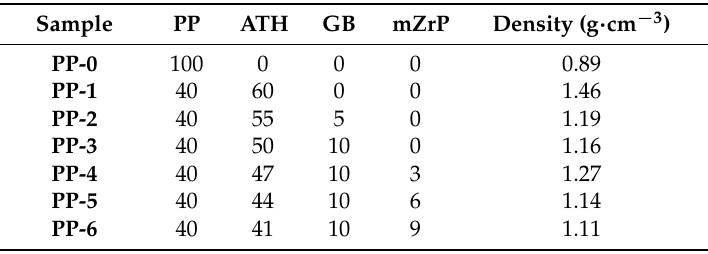
Table 1. Formulation and density of polypropylene (PP)